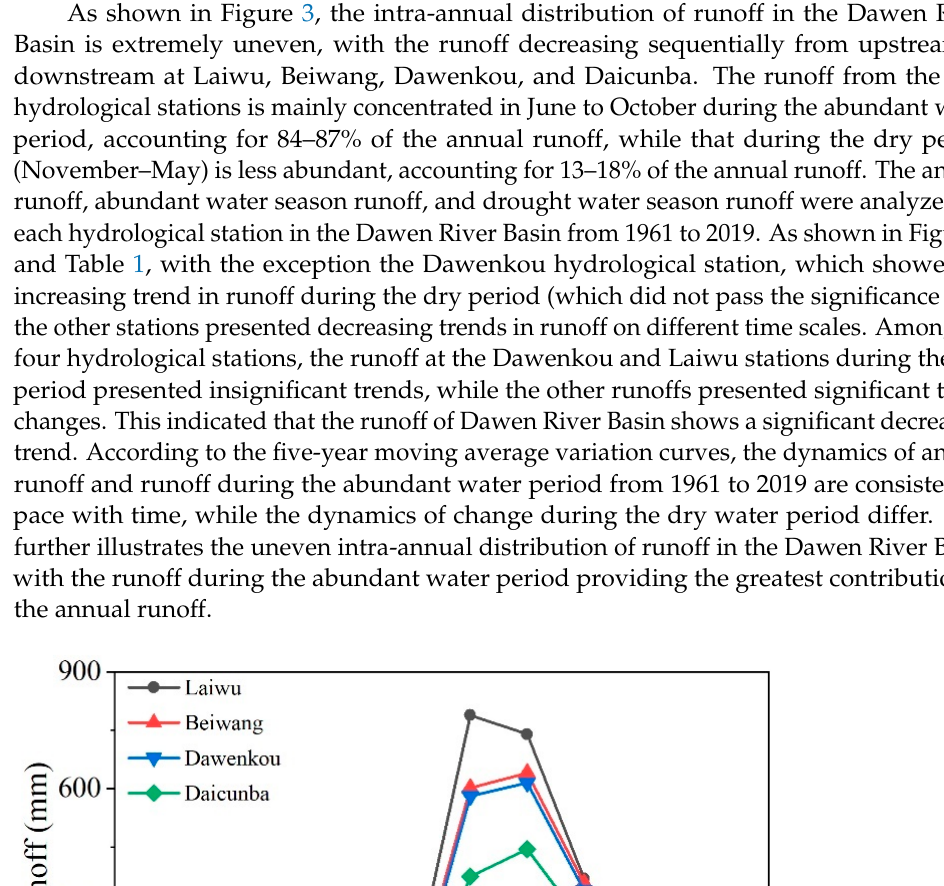
Figure 4. The trend analysis for annual runoff in the Dawen River Basin.